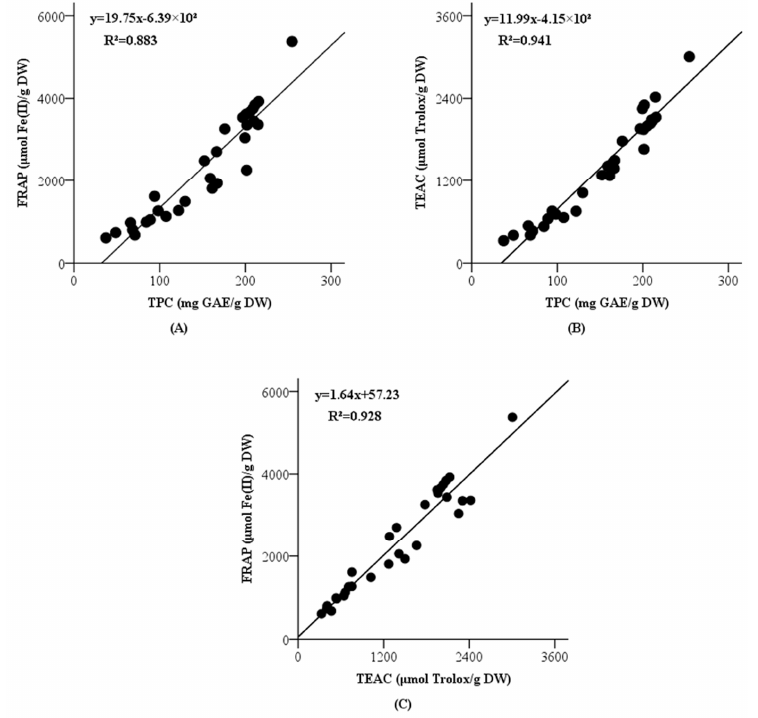
Figure 1. Correlations among FRAP and TPC values ( A ), TEAC and TPC values ( B ), FRAP and TEAC values ( C ). Abbreviations: FRAP, ferric-reducing antioxidant power; TEAC, Trolox equivalent antioxidant capacity; TPC, total phenolic content.